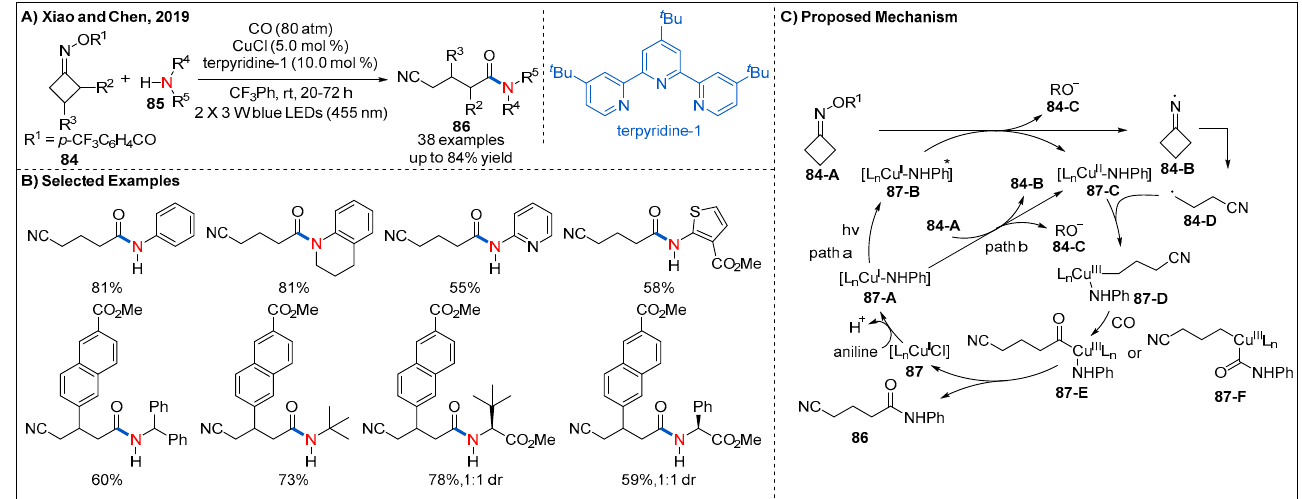
Figure 27. Visible-light-induced copper-catalyzed radical aminocarbonylation of redox-active cy- cloketone oxime esters.